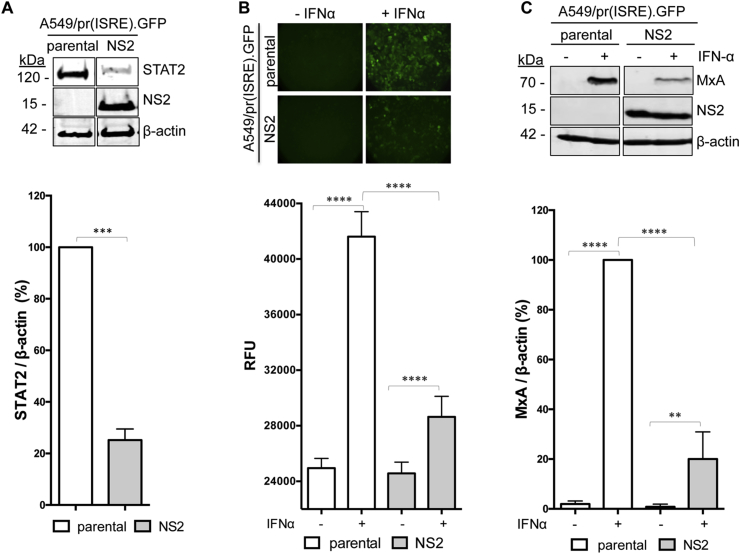
Characterization of the A549/pr(ISRE).GFP-NS2 reporter cell-line. (A) Detection of NS2, STAT2 and β-actin in A549/pr(IFNβ).GFP or A549/pr(ISRE).GFP-NS2 reporter cells. Cells were lysed and subjected to SDS-PAGE/Western blot, followed by detection with anti-myc, anti-STAT2 and anti-β-actin antibody and IRDye680-conjugated secondary antibody. Bands were visualized using an Odyssey near-infrared scanner and STAT2 levels quantified as % STAT2 relative to β-actin. Statistical significance was assessed using a two-tailed paired T-test; ***, p < 0.0005. Data shown represents mean values from four independent experiments; error bar = SD. (B) Effect of NS2 on eGFP reporter gene expression upon activation of the IFN signaling pathway. A549/pr(ISRE).GFP or A549/pr(ISRE).GFP-NS2 reporter cells were incubated with IFNα to activate the IFN signaling pathway. Forty-eight hours post-IFNα treatment, eGFP expression was visualized and measured as raw fluorescent units (RFU). Data shown represents three independent experiments each with 12 replicates; error bars = SD. Statistical significance was assessed using a two-way ANOVA with Tukey's multiple comparisons test; ****, p < 0.0001. (C) Effect of NS2 on ISG MxA expression upon activation of the IFN signaling pathway. A549/pr(ISRE).GFP or A549/pr(ISRE).GFP-NS2 reporter cells were incubated with IFNα. Sixteen hours post-IFNα treatment, cell lysates were subjected to SDS-PAGE/Western blot followed by detection with anti-MxA, anti-myc or anti-actin antibody and IRDye800-conjugated secondary antibody. Bands were visualized using an Odyssey near-infrared scanner and MxA levels quantified as % MxA relative to β-actin. Statistical significance was assessed using a two-way ANOVA with Tukey's multiple comparisons test; ****, p < 0.0001, **, p < 0015. Data shown represents mean values from four independent experiments; error bar = SD.